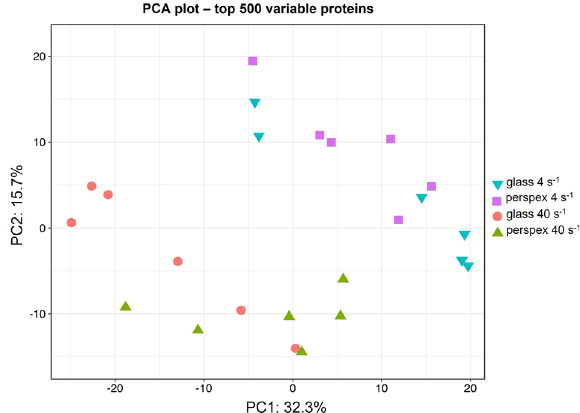
Fig. 4 Principal Component Analysis (PCA) of the proteins identi fi ed from marine bio fi lms formed by fi lamentous cyano- bacteria under four different bio fi lm growing conditions. The PCA plot displays a grouping pattern among the six replicates studied from each bio fi lm condition formed on glass and perspex, but some differences were observed between the two hydrodynamic condi- tions studied (4 s − 1 and 40 s − 1 ). The two principal components extracted (PC1 and PC2) can explain 48% of the total variability revealed among the proteins analysed. PCA was performed with the respective function provided within the “ DEP ” R package 101 , used for the downstream proteomic analyses.